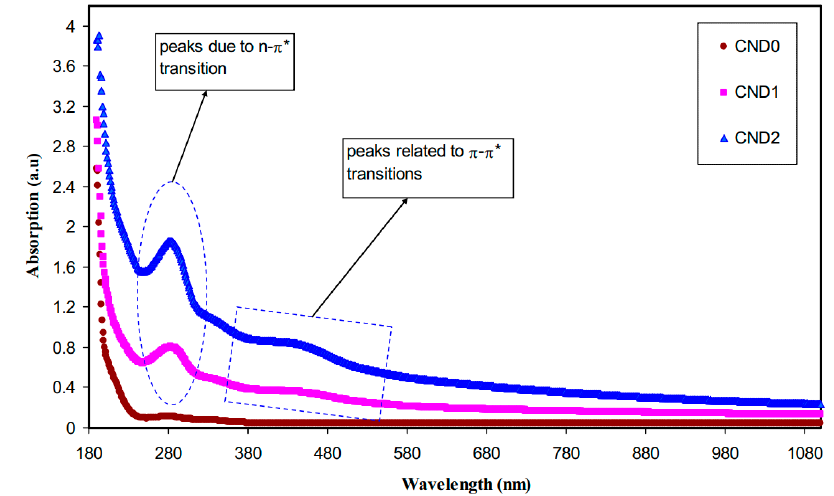
Figure 19. Films absorption spectra. Obviously, with a rising amount of carbon nanodots (CNDs), the absorption changes to longer wavelengths. All films were specified as CND0, CND1 and CND2 equivalent to doped PVA solution with 0 mL, 15 mL and 30 mL of 5 mg of dissolved CNDs, correspondingly [191].